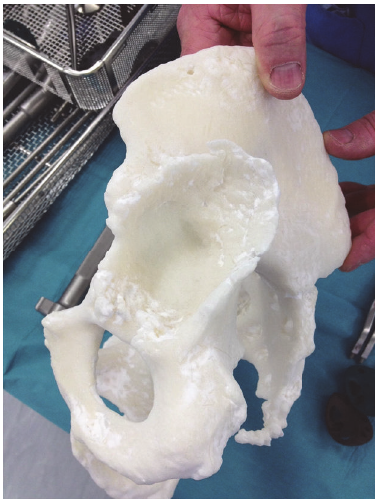
Figure 12: Examining the left acetabulum showing a posterosu- perior deficiency. The right acetabulum shows significant central discontinuation due to bone loss (note: these figures in print journal are two-dimensional, thus limiting the true demonstration of the value of 3D printed models in providing an accurate understanding and representation of the complex deformities and corrective reconstructive techniques).